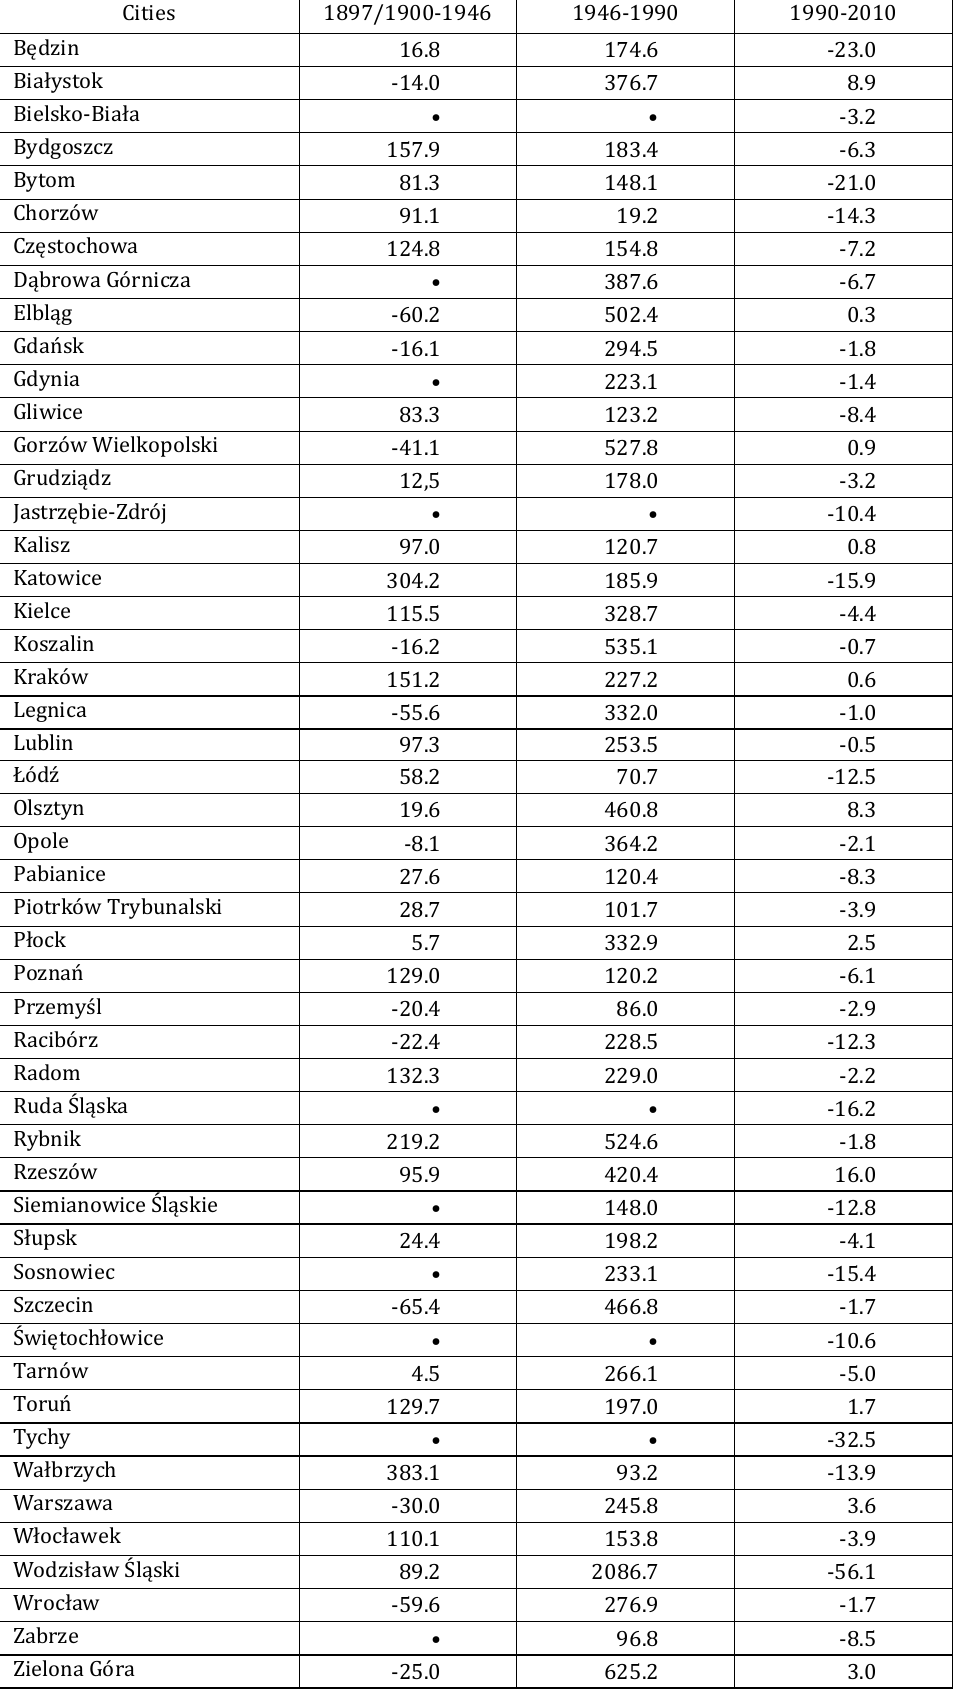
Table 2. Dynamics of population in studied cities of Poland (in %)